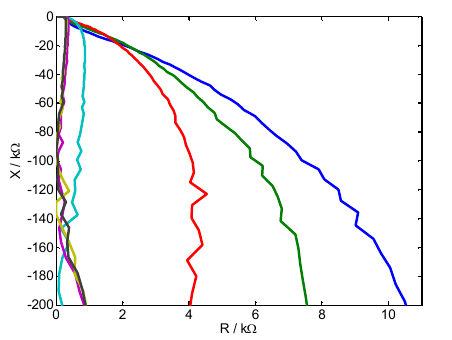
Fig.21: Locus diagram for the impedance of a 3 µm interdigitated electrode immersed in KCl-solution of different concentration. (along the arrow: 1 µM, 10 µM, 100 µM ,1 mM, 10 mM, 100 mM, 1 M). The frequency ranged from 500 Hz to 40 MHz. Note the different scaling of the axes.